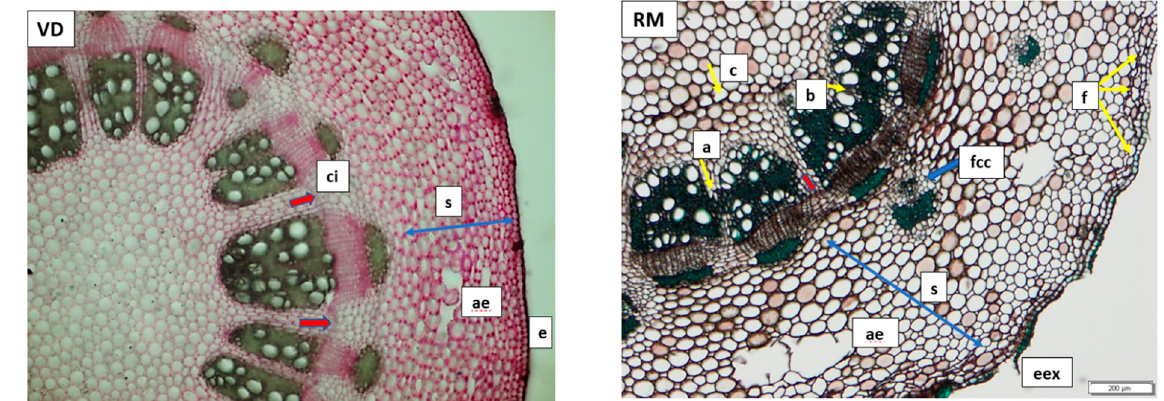
Figure 3. Transversal section of the T. farfara rhizome. Left: Vatra Dornei sample (VD); right: Rar ă u Mountains sample (RM). Legend: e—epidermis; eex—exfoliated epidermis; s—cortex; ae— aerenchyma; ci—interfascicular cambium; f—phellogen; fcc—cortical bundle; a—interior libriform; b—wood vessels; c—parenchymatic cells.